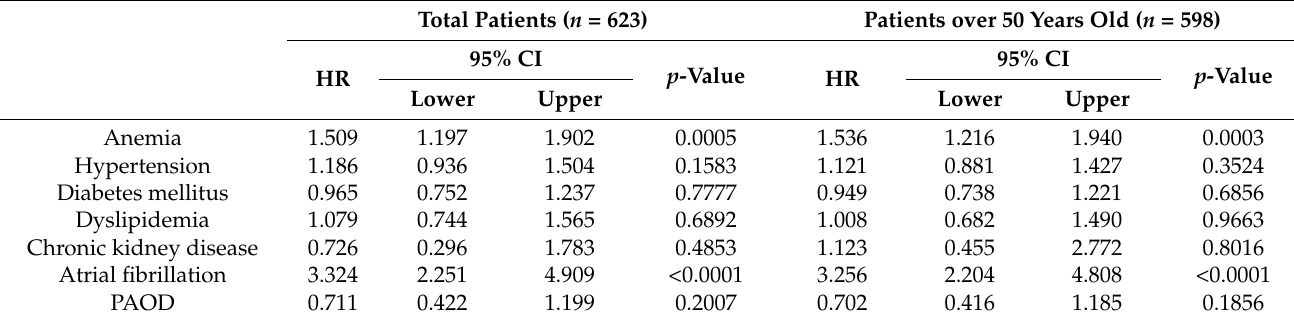
Figure 2. Kaplan-Meier survival curve of the patients with ischemic stroke. Survival rate was lower in patients with anemia. Table 4. Analysis of the risk of death in patients diagnosed with ischemic stroke.